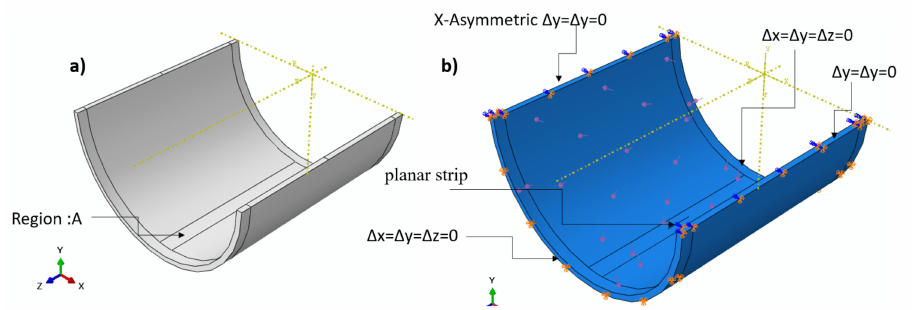
Figure 2. FE ( a ) solid domain, ( b ) boundary condition domain.